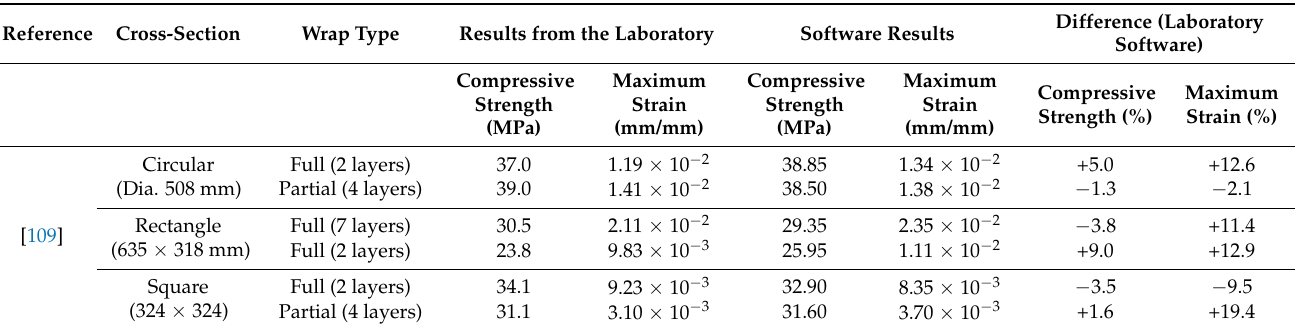
Table 7. Difference between software and experimental results for maximum axial strain and com- pressive